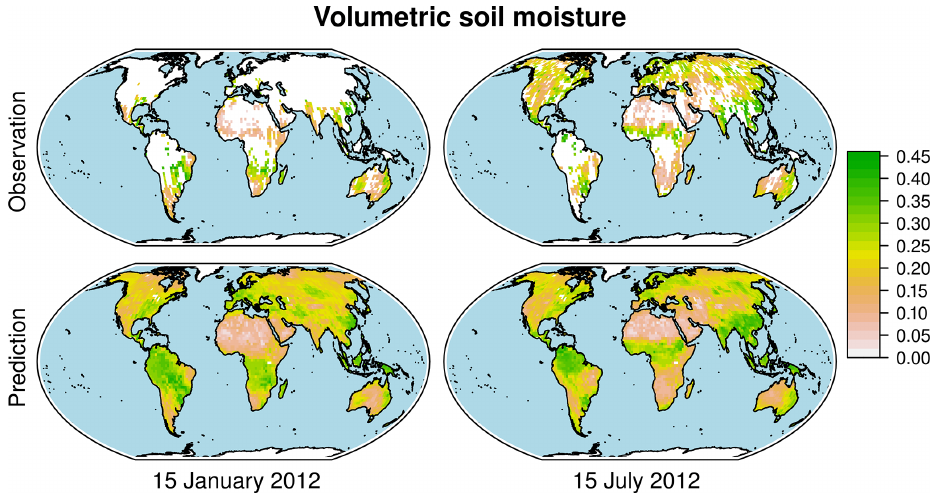
Figure 7. Global distribution of the observed and predicted volumetric soil moisture on a Northern Hemisphere winter (15 January 2012) and summer (15 July 2012) day in the training